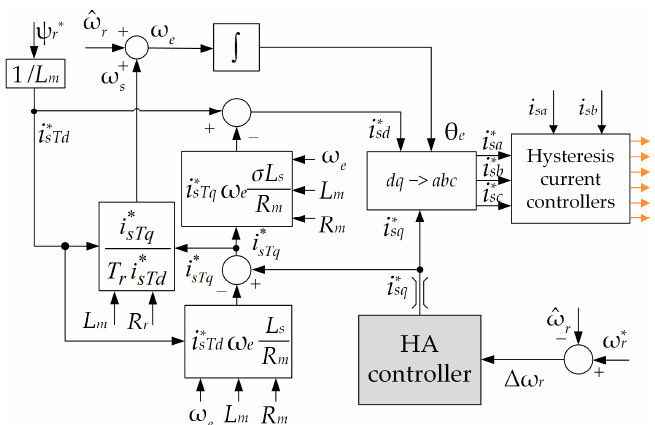
Figure 7. Block diagram of the speed-sensorless IRFO control algorithm.